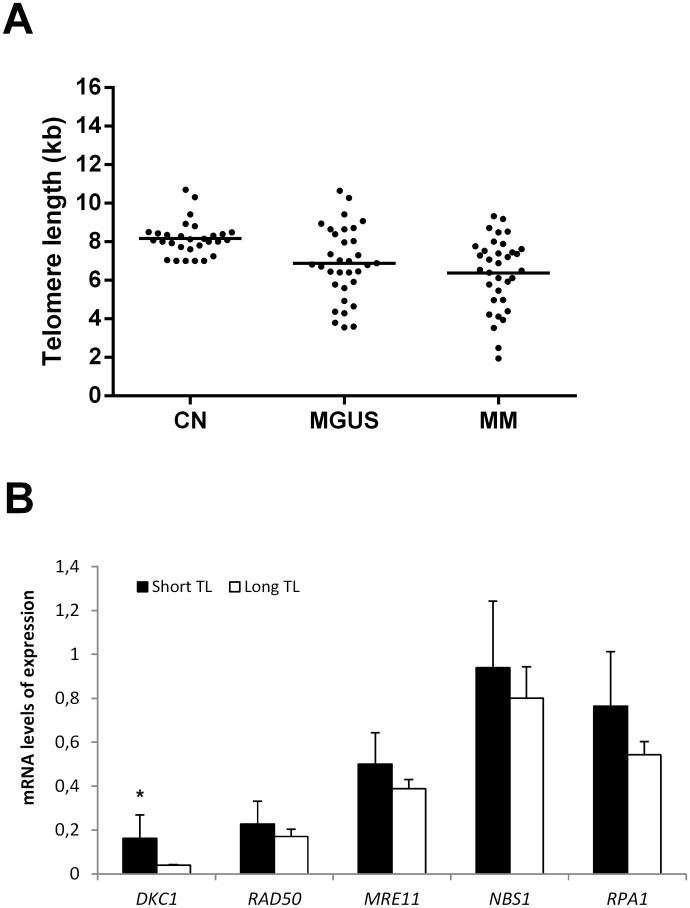
Relationship between telomere length (TL) and gene expression.A) TL was measured in 30 normal controls (NC), 33 patients with MGUS and 34 with MM. Solid lines indicated in each group represent the mean TL. Results showed significantly reduced TL in MM and MGUS patients compared with normal controls (p≤0.0005 and p≤0.002, respectively). There was no significant difference in TL between pathologies. B) Influence of TL on gene expression in MM. Patients were divided into two groups with a cutoff value of 6.15 kb, obtained by ROC curve analysis. Short TL: telomeres ≤6.15kb; Long TL: telomeres >6.15kb. *Significant differences were observed for DKC1 expression (p = 0.026).